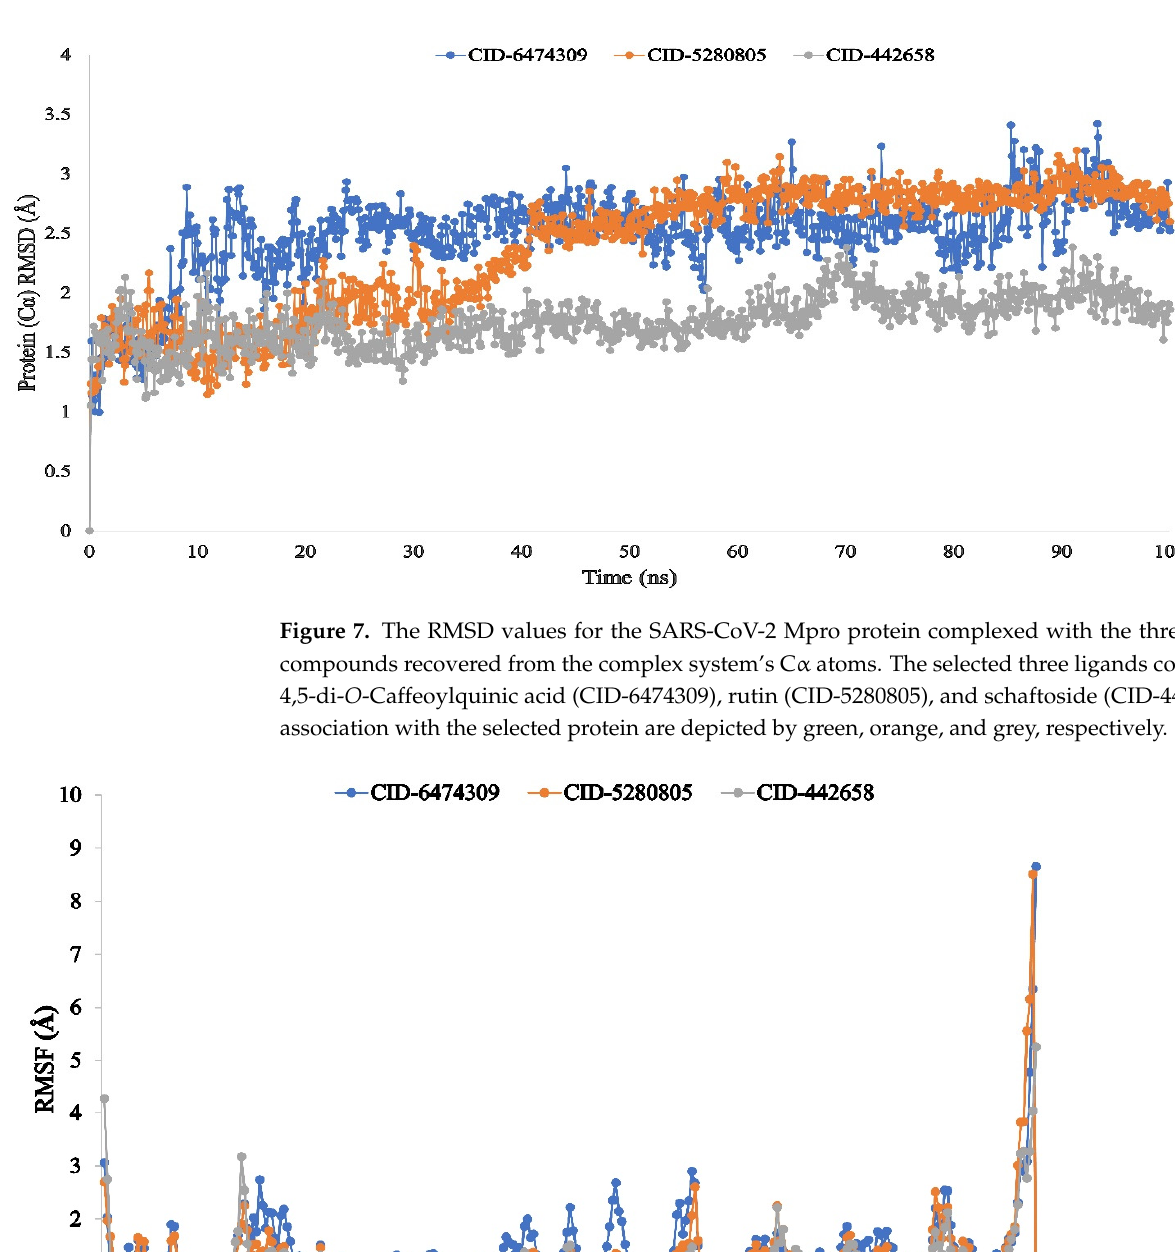
Figure 8. The RMSF values were determined for the protein C α atoms in the docked protein–ligand complexes. The selected three ligand compounds 4,5-di- O -Caffeoylquinic acid (CID-6474309), rutin (CID-5280805), and schaftoside (CID-442658) in association with the selected protein are depicted by green, orange, and grey,